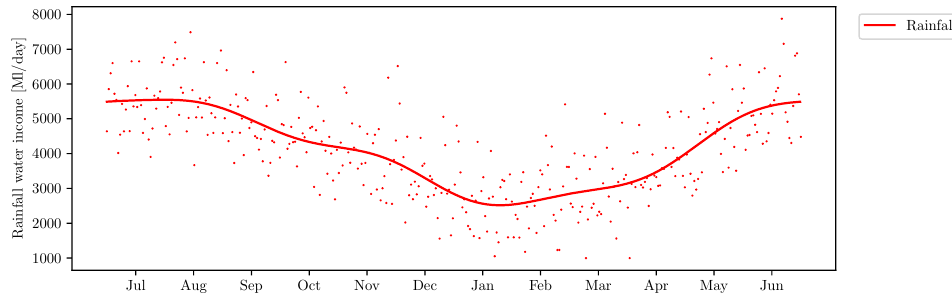
Figure 3. Normalized rainfall daily averages (dotted line) and the approximation (solid line). Specifying of the upper and lower bounds for the control parameters ) T and ¯ u = ( ¯ u E , ¯ u u = ( u , u , u , u , u E SM Ca EG GR